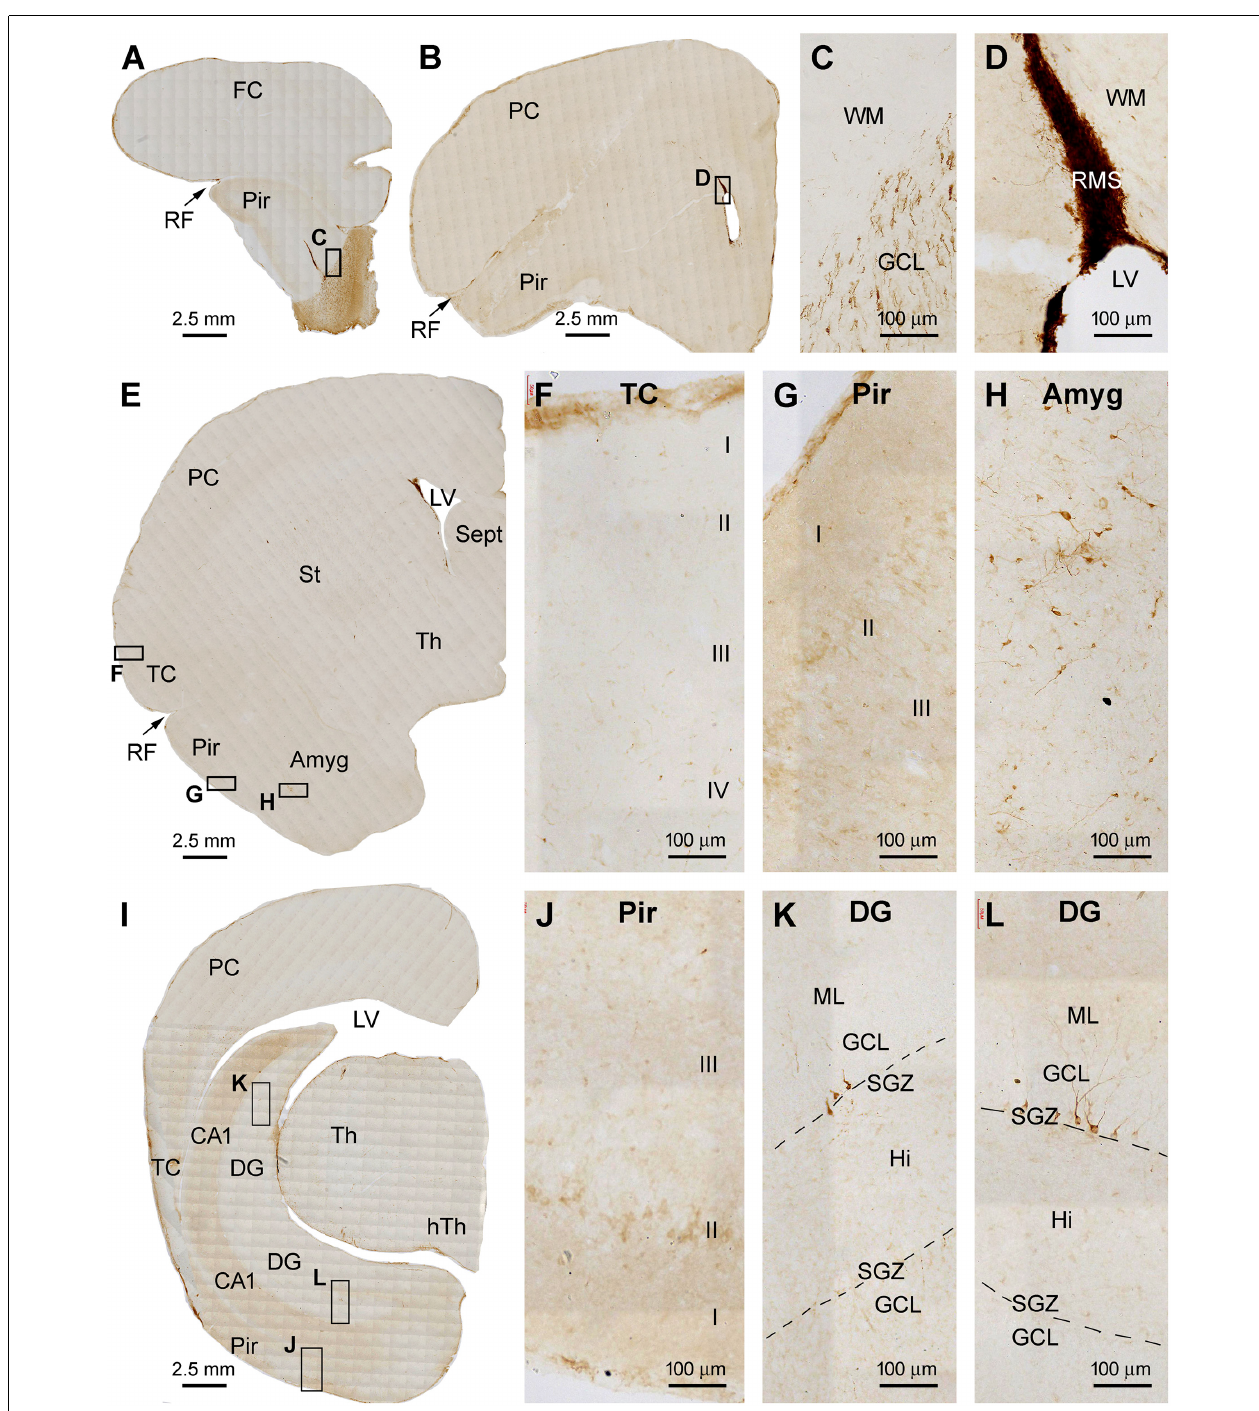
FIGURE 5 | Representative images illustrating DCX+ cellular profiles in the forebrain in a 6 years-old Chinese tree shrew. Overall, the amount of labeling in the forebrain structures is apparently reduced relative to that seen in Figure 4. Panels (A–D) are low and high magnification images illustrating the labeling in the olfactory bulb (OB) in the granule cell layer (GCL), and along the rostral migratory stream (RMS). Panels (E–G) are low and high magnification images at the level of the septum. There are no labeled cells in the temporal and parietal neocortex (E,F) . However, some lightly stained neurons are seen in the piriform cortex in layers II (E,G) , while some distinctly labeled neurons remain in the amygdala (E,H) . Panel (I) is the image of the immunolabeled section passing the temporal hippocampus, with labeled DCX+ cells seen in the piriform cortex (J) and a few clusters of labeled granule cells remained in the dentate gyrus (K,L) . Abbreviations are as defined in Figures 1 – 3 . Scale bars are as